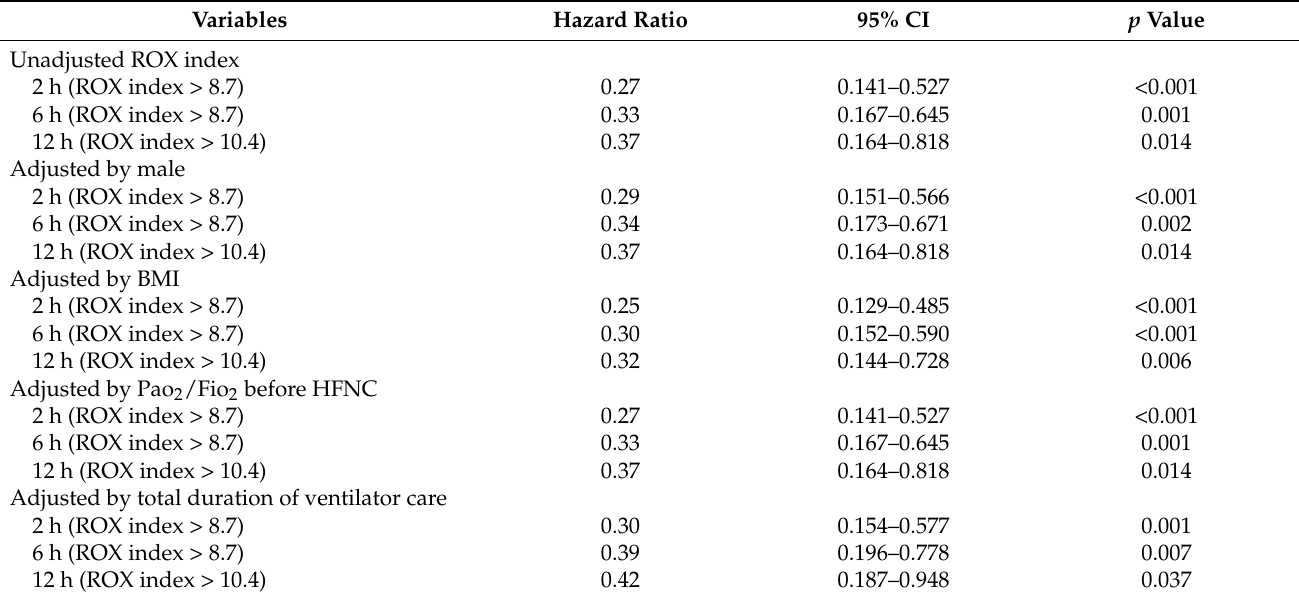
Table 3. Cox proportional hazard model analyzing the ROX index at different time points of high-flow nasal cannula therapy application adjusted by potential covariates for the risk for reintubation.